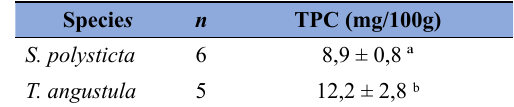
Table 4. Total polyphenol content (TPC) in mg / 100 g for samples (n) of S. polysticta and T. angustula honeys (seven days after harvest; storage at 4 °